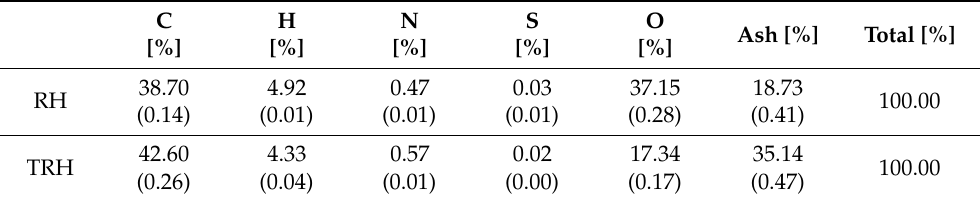
Table 1. CHNSO elemental and ash composition of raw rice hulls (RH) and torrefied rice hulls (TRH). Standard deviation is listed within parentheses. Ash content was calculated by difference.